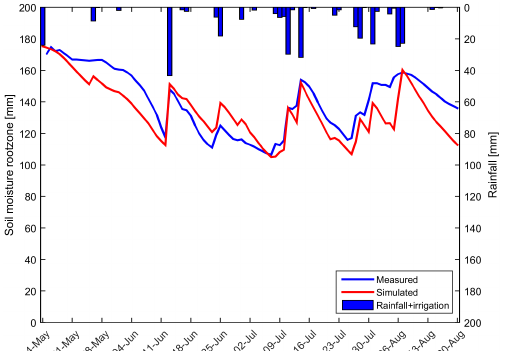
Figure 5. Measured and simulated daily root-zone soil moisture content during the 2014 growing season. Rainfall + irrigation has been measured by the rain gauge that was attached to the moisture sensor.